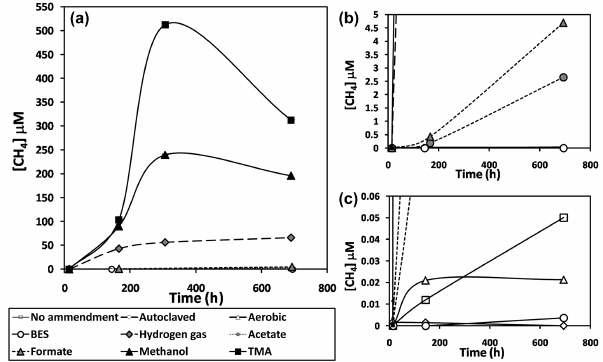
Figure 4. (a) Headspace methane concentrations in sediment slurry incubations. (b) Expansion of (a) , showing results for acetate, for- mate, and controls. (c) Expansion of (a) , showing results for con- trols only. Error bars represent 1 standard deviation for triplicate sample